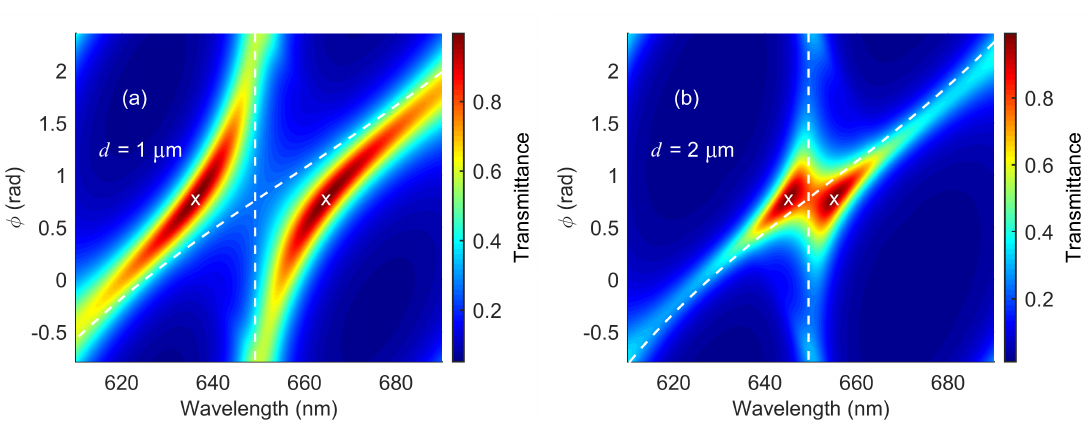
Figure 5. Transmittance of the structure from Figure 1 as a function of angle ϕ at different CLC widths d . ( a ) d = 1 µ m and ( b ) d = 2 µ m. White lines show the positions of single OTSs calculated using Equation (6). The crosses correspond to OTS wavelengths for ϕ = π